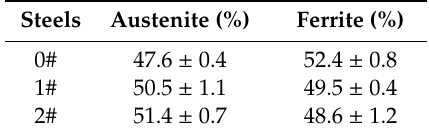
Table 7. Proportions of two phases of the 0#–2# experimental samples.